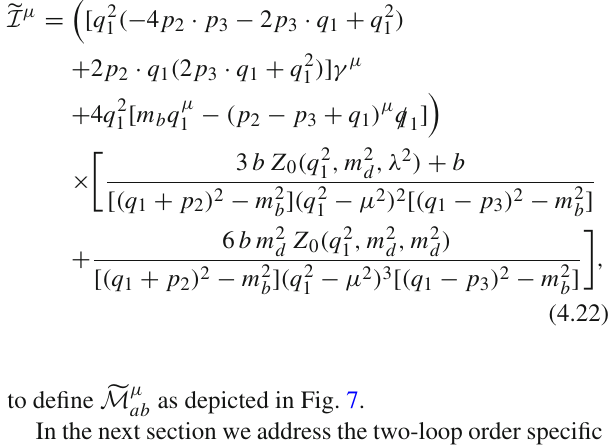
( M μ Thus , the amplitude which defines the two-loop ab order UV divergence after subtracting the subdivergences, is obtained by substituting I μ